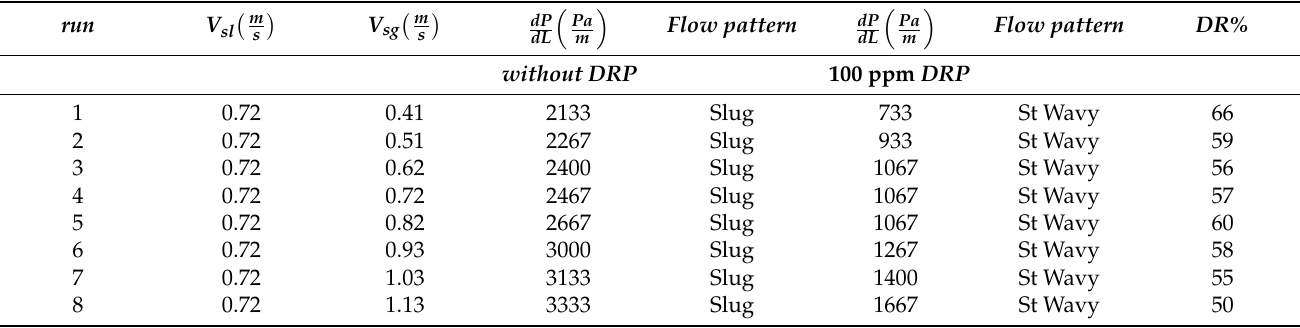
Table A3. Frictional Pressure Drop and Transition of the Slug Flow Regime Using 100 ppm